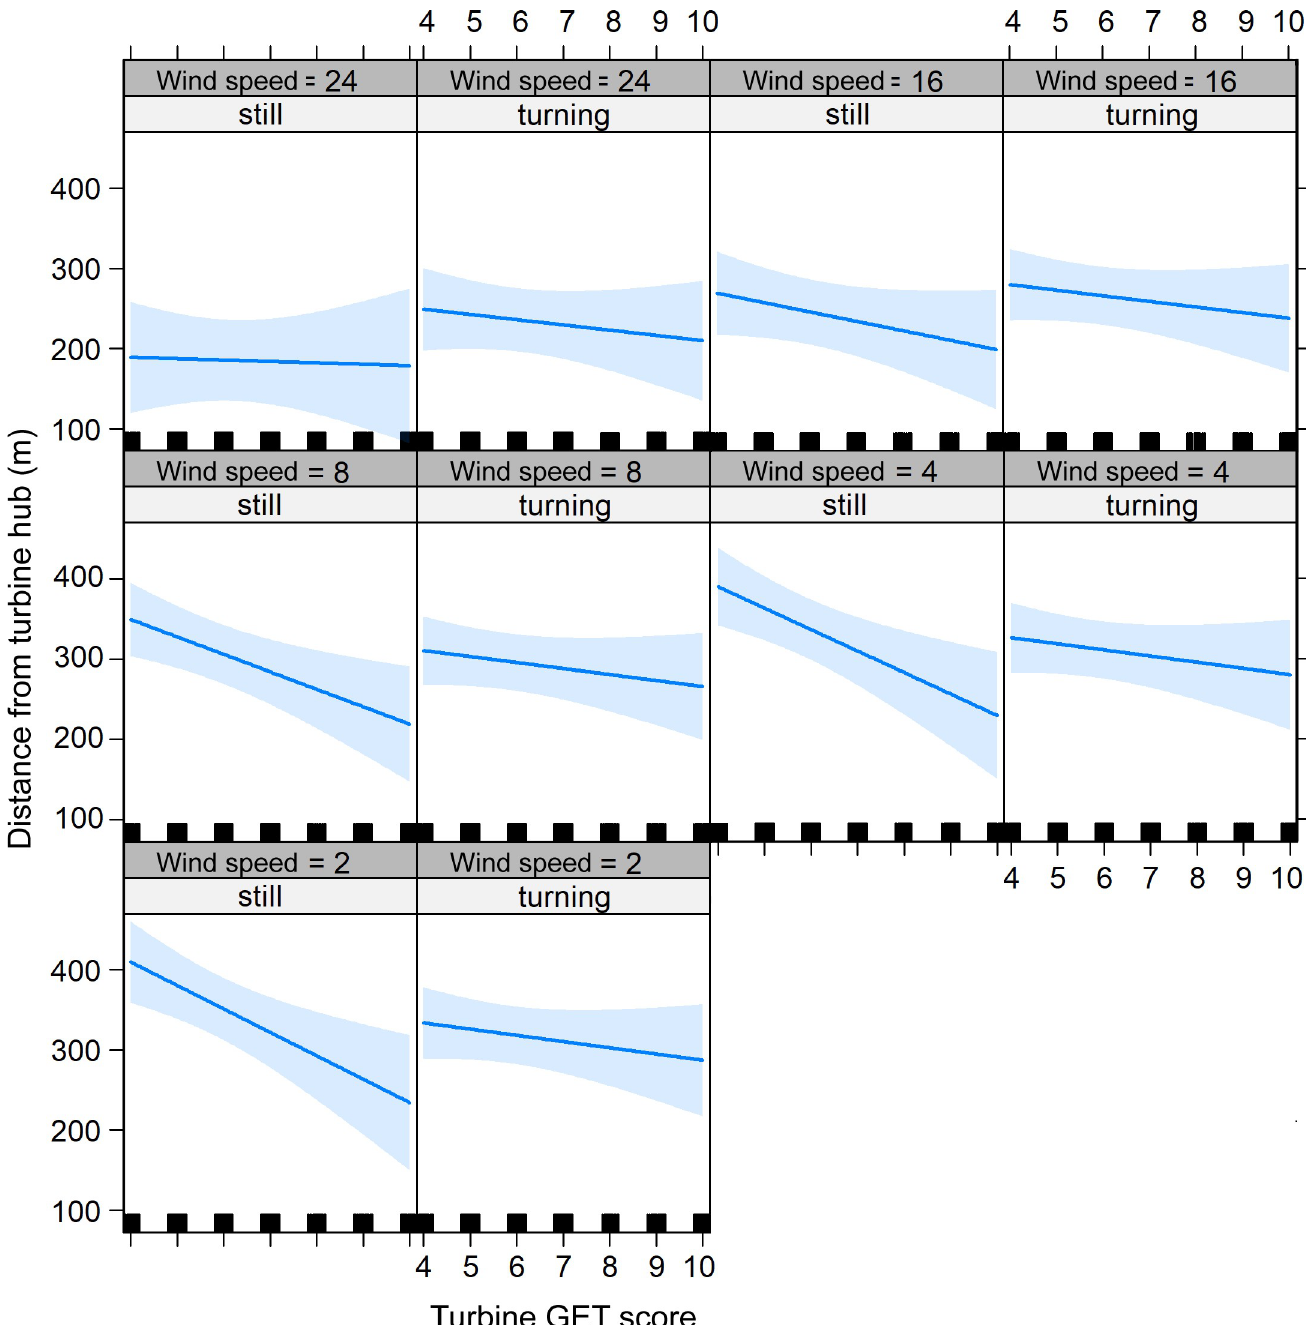
Fig 7. Turbine GET effect plot showing the relationship between the fitted distance to the nearest turbine hub (y) and the GET score at a turbine’s location. The panels show how the relationship was conditional on wind speed (m s -1 ) and whether the turbine blades were still or turning. Blue lines and blue shading show the mean and 95% CL ranges,